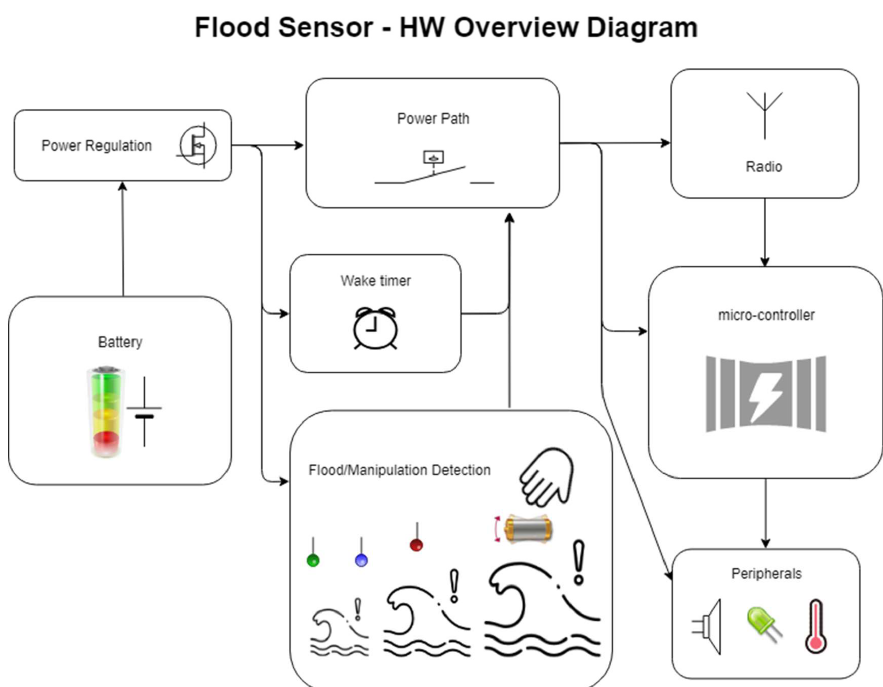
Figure 1. Hardware overview diagram for the flood sensor.